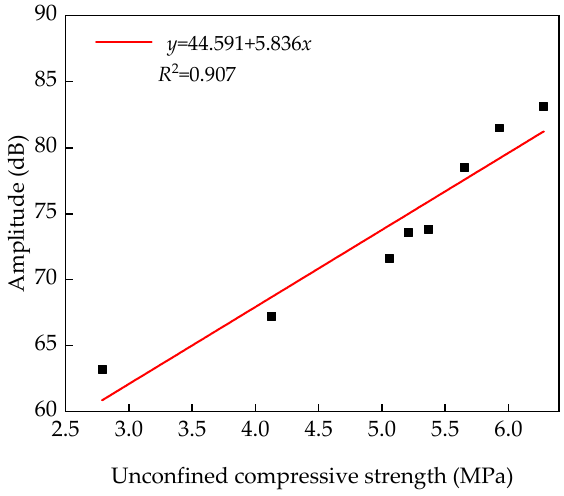
Figure 17. Fitting results of unconfined compressive strength and amplitude. From the fitting results shown in Figure 17, Equation (6) can be obtained.